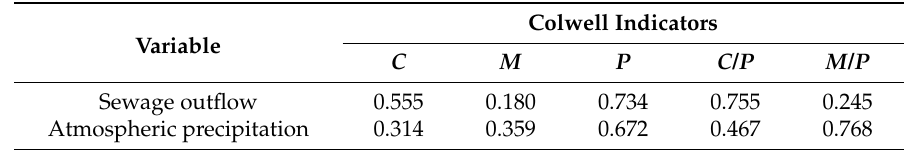
Table 3. The values of the Colwell indicators for the average monthly the sewage outflows and the average monthly amount of atmospheric precipitation.